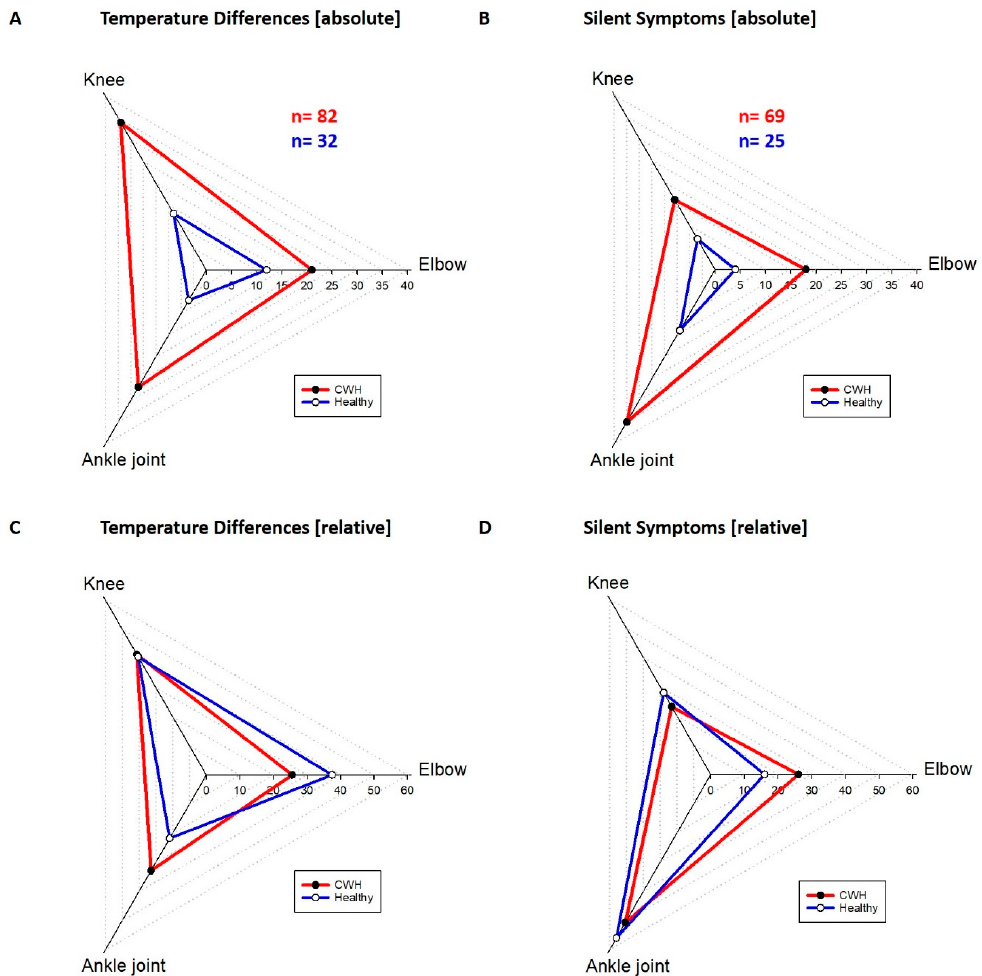
Figure 4. Absolute distribution of temperature differences ( A ) and silent symptoms ( B ) in children with hemophilia and healthy children. The sum of temperature differences was in the hemophilic group 82 and in the healthy group 32. 69 silent symptoms appeared in hemophilic children and 25 in healthy children. The relative appearance of temperature differences ( C ) and silent symptoms ( D ) among the different joints for healthy children and children with hemophilia.